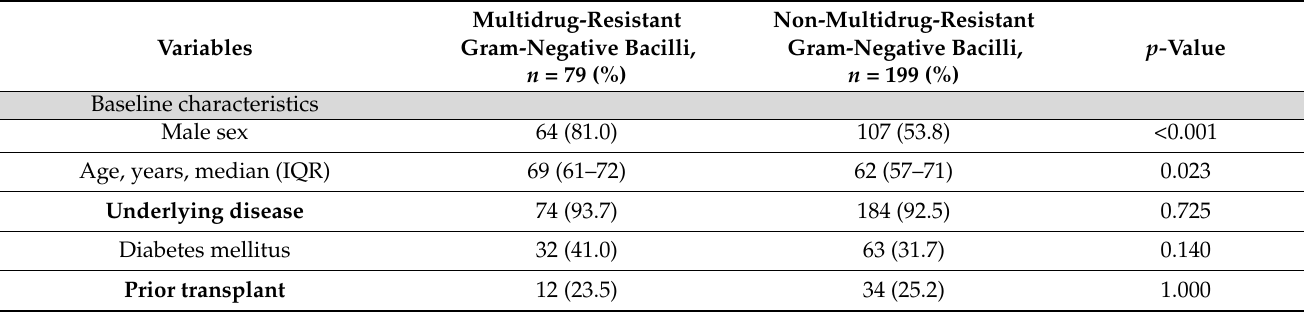
Table 3. Comparison of baseline and clinical characteristics in 278 episodes of acute graft